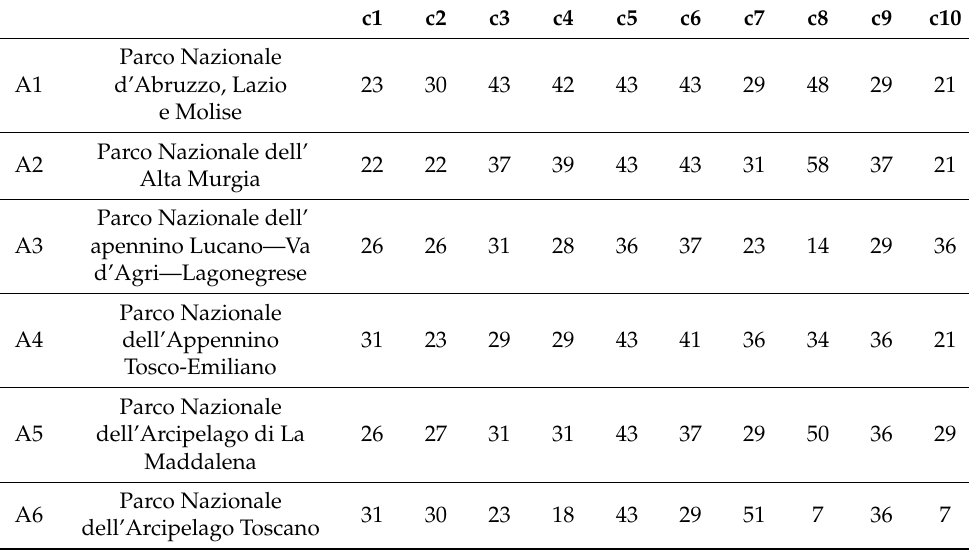
Table 3. The geometric mean of the values of the criteria for all